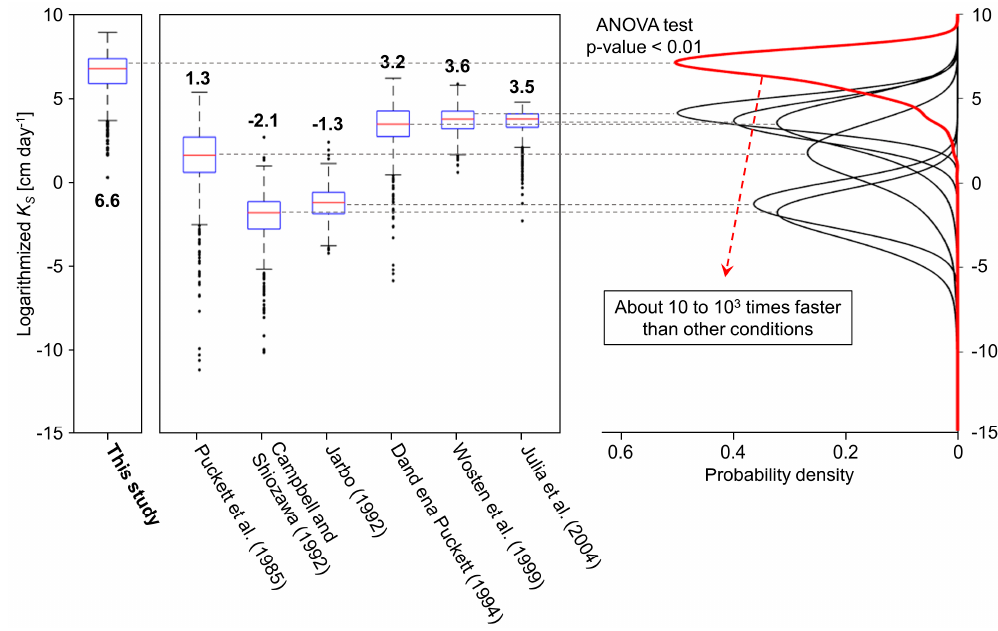
Figure 3. Mean values and ranges of the observed logarithmized K s (saturated hydraulic conductivity) of forest soil in South Korea (this study), predicted logarithmized K s based on PTFs presented in the literature, and kernel probability density functions of these logarithmized K s . Six PTFs did not focus on the forest soil, and there are di ff erent ranges of the soil properties that previous research used. Table 5. Relationship between ln ( K s ) and the best treatment of explanatory